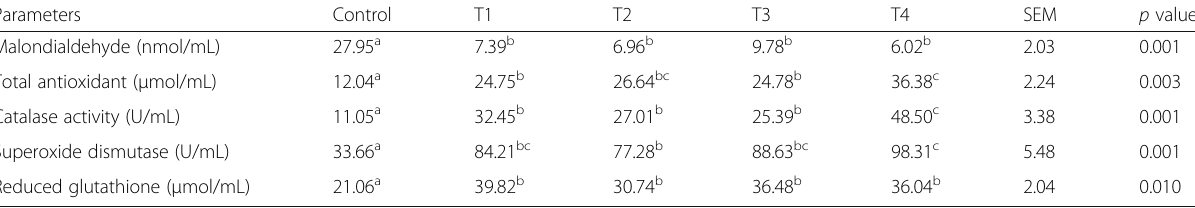
Means with different superscript letters along the rows are significantly different ( p < 0.05) for each of the parameters measured. Control — no supplementation, T1 — group supplemented with 200mg Chlorella vulgaris biomass, T2 — group supplemented with 300mg Chlorella vulgaris biomass, T3 — group supplemented with 400mg Chlorella vulgaris biomass, and T4 — group supplemented with 500mg Chlorella vulgaris